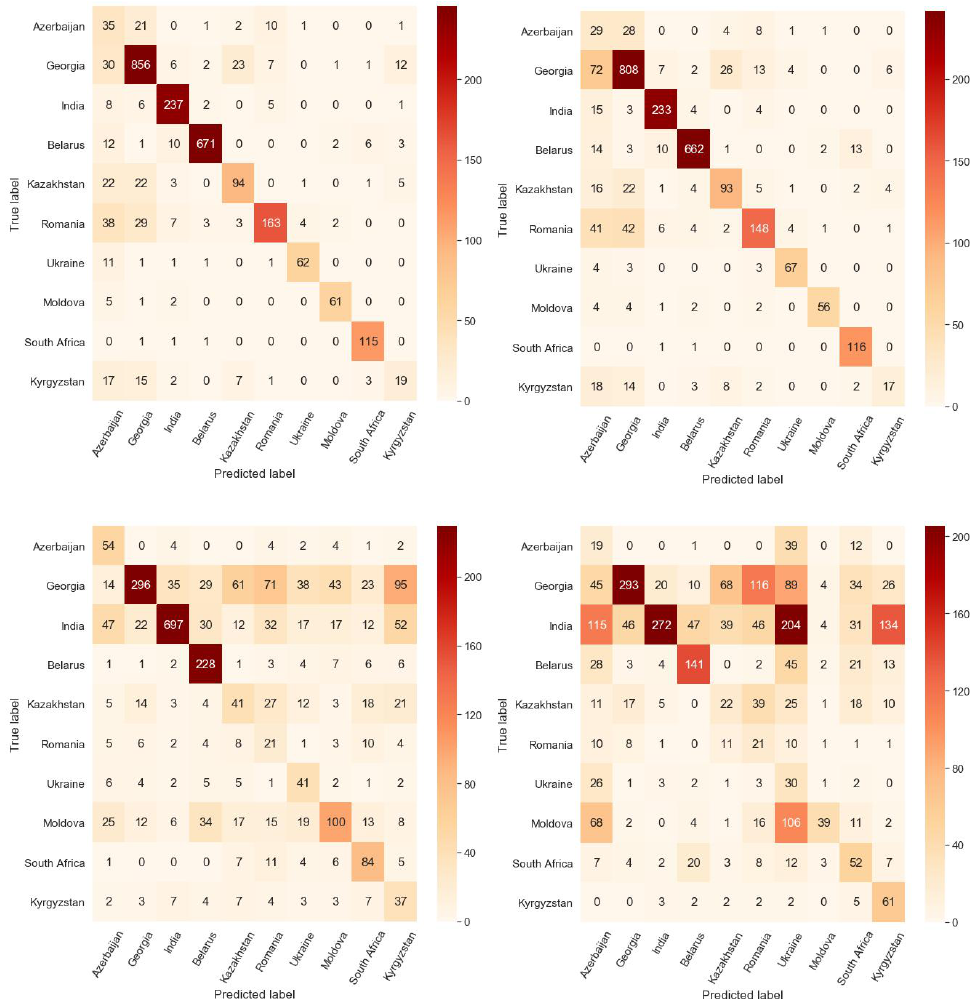
Figure 12. Summation of confusion matrices on test sets from 5 folds on the country-of-origin classi- fication task. ( top-left ) Lung-segmented images, ( top-right ) histogram-equalized lung-segmented images, ( bottom-left ) radiological and demographic features and ( bottom-right ) radiological features. Note that the image-derived features have a significantly better performance than the disease-specific radiological